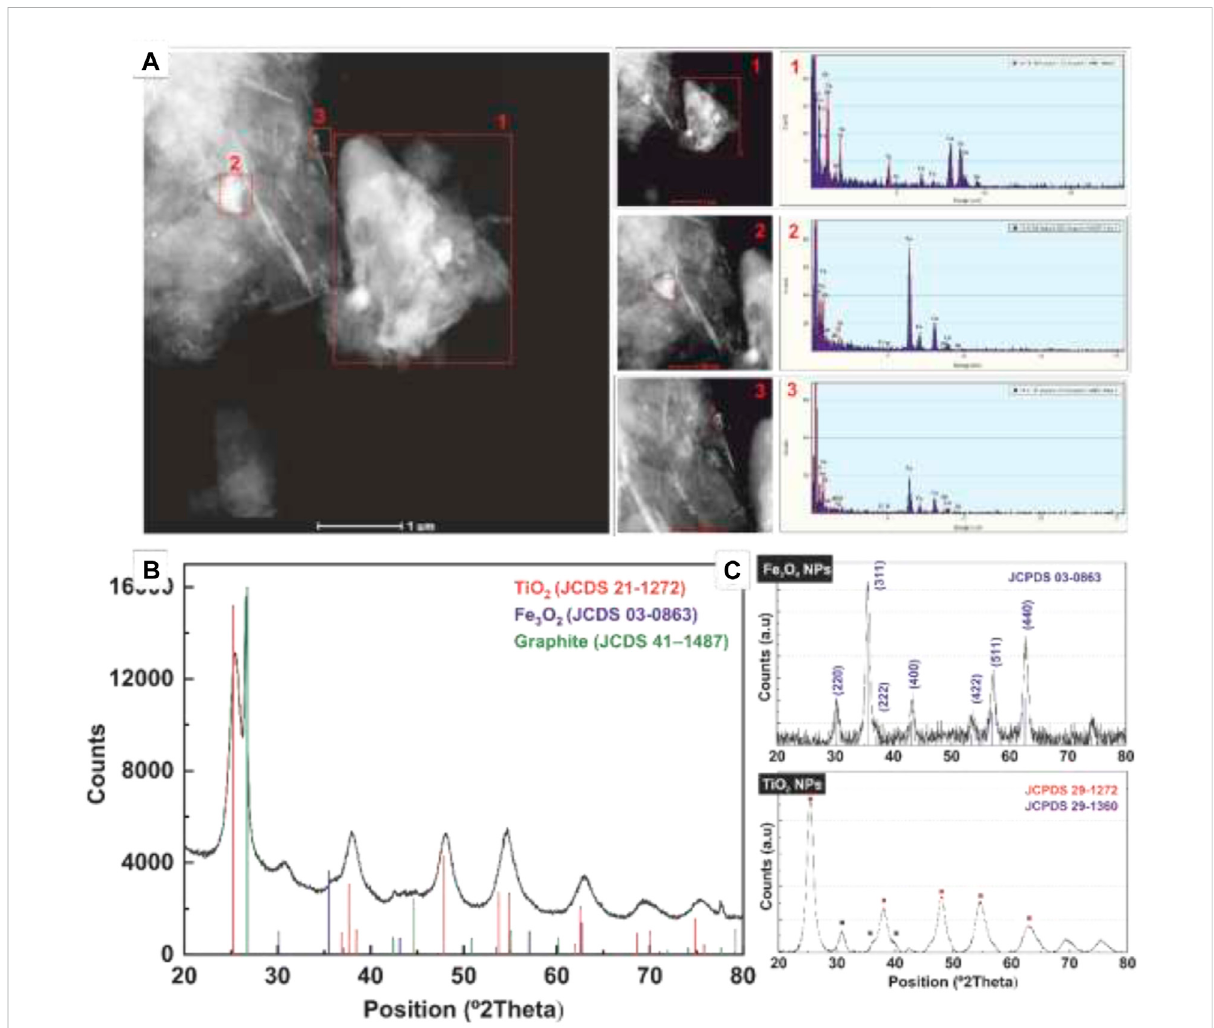
FIGURE 2 (A) EDS analysis of the Graphene/Fe3O4/TiO 2 hybrids structures. Scan pro fi les extracted from the representative sections of the HAADF-STEM images(aslabelled)con fi rmedthepresenceofbothtypesofNPsatthesurfaceofthegraphenesheet.TheCupeaksarethesignaldetectedfromthe TEMgrid. (B) XRD of Graphene/Fe 3 O 4 /TiO 2 structures. (C) XRD ofFe 3 O 4 and TiO 2 NPs. (A) reveal theformation of highly uniform particleswith well- de fi ned morphologies. Structural characterization by X-ray diffraction (Supplementary Figure S1) shows well-de fi ned peaks accordingly to the high crystallinity of the